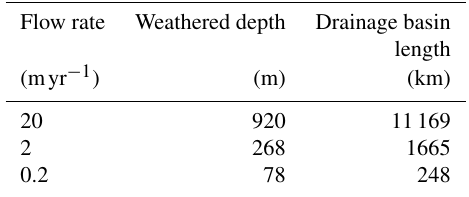
Table 2. Predicted spatial scales at 150Myr for various flow